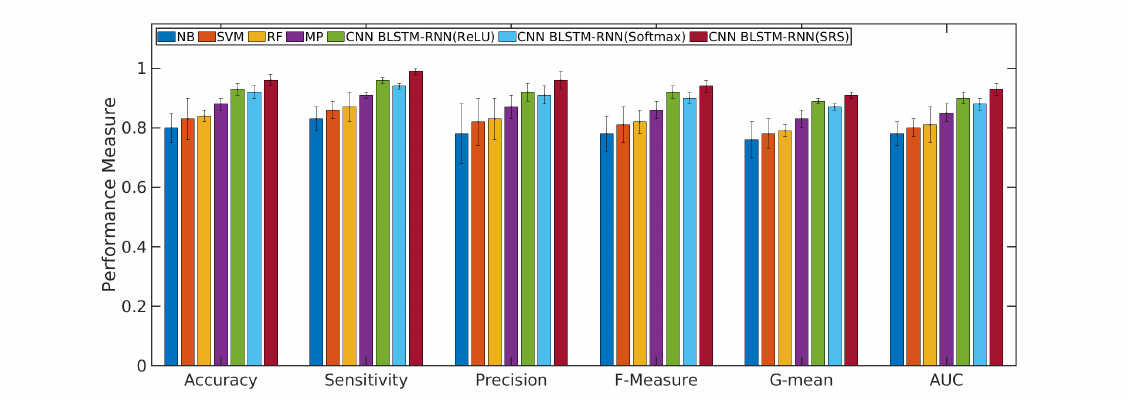
Figure 6. Results of machine learning algorithms to classify the topic of non weak signal.